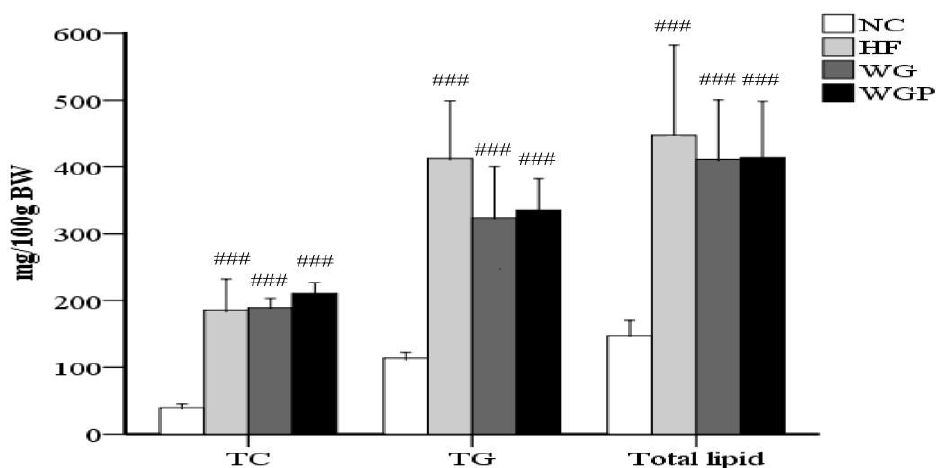
Figure 2. The effects of wheat germ and wheat germ protein on the liver lipid profile of high-fat diet-induced rats. TG, triglycerides; TC, total cholesterol. Values are presented as means ± SEMs ( n = 5). ### p < 0.001 vs. NC group.